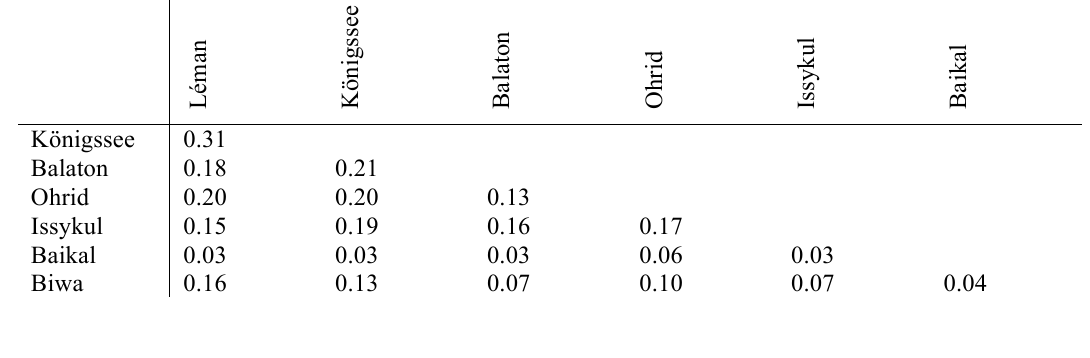
Table 1. Jaccard similarity indices for freshwater nematodes of the seven temperate lakes mentioned in fig. 2. Lake Baikal presents the lowest values, indicating its biological